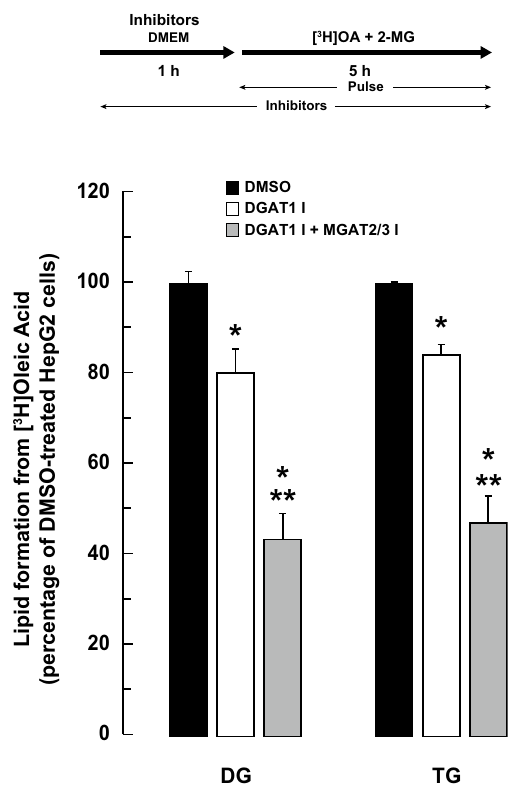
Figure 4. Effect of DGAT1 inhibition on lipid production from exogenous 2-MG and oleic acid. HepG2 cells were pre-incubated with or without the DGAT1 inhibitor (5 µM) or the DGAT1, MGAT2 (25 µM) and MGAT3 (50 µM) inhibitors together. After 1 h, 5 µCi [ 3 H]OA, cold OA (0.25 mM final concentration) and 2-MG (0.2 mM final concentration) were added to the culture media and cells were incubated for a further 5 h. The incorporation of radioactivity into TG and DG in cells was then determined. Values for DMSO-treated controls: DG (22.3 × 10 3 dpm/mg cell protein), TG (421 × 10 3 dpm/mg cell protein). * p < 0.001 versus DMSO-treated cells; ** p < 0.001 DGAT1 inhibitor versus DGAT1, MGAT2 and MGAT3 inhibitors